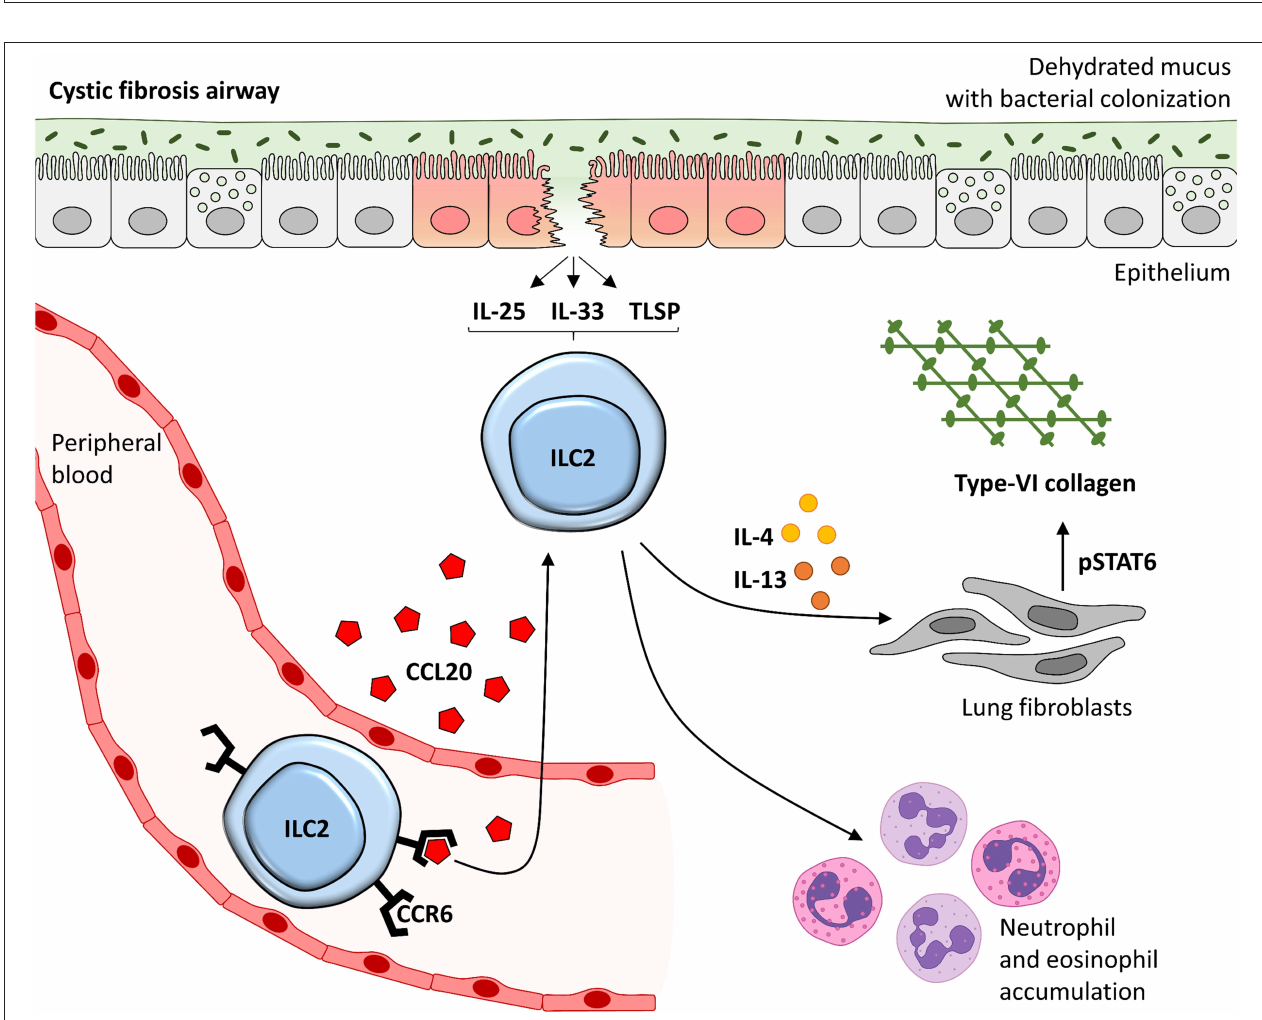
FIGURE 7 | Suggested model of the CCL20 - ILC2 – IL-4/IL-13 – Col VI axis in lung disease of CF patients. CCR6 expressing ILC2s in the peripheral blood stream are chemoattracted into the inflamed lung tissue of CF patients in a CCL20-dependent manner. Locally accumulated and activated pb-derived ILC2s likely induce type-2 mediated lung inflammation, including neutrophils and eosinophil accumulation, but also pulmonary Col VI expression in lung fibroblasts. This is mediated via the secreted mediators IL-4 and IL-13 in particular which signal via STAT6. This might finally lead to local tissue remodeling potentially driving disease progression in CF patients. TSLP, thymic stromal